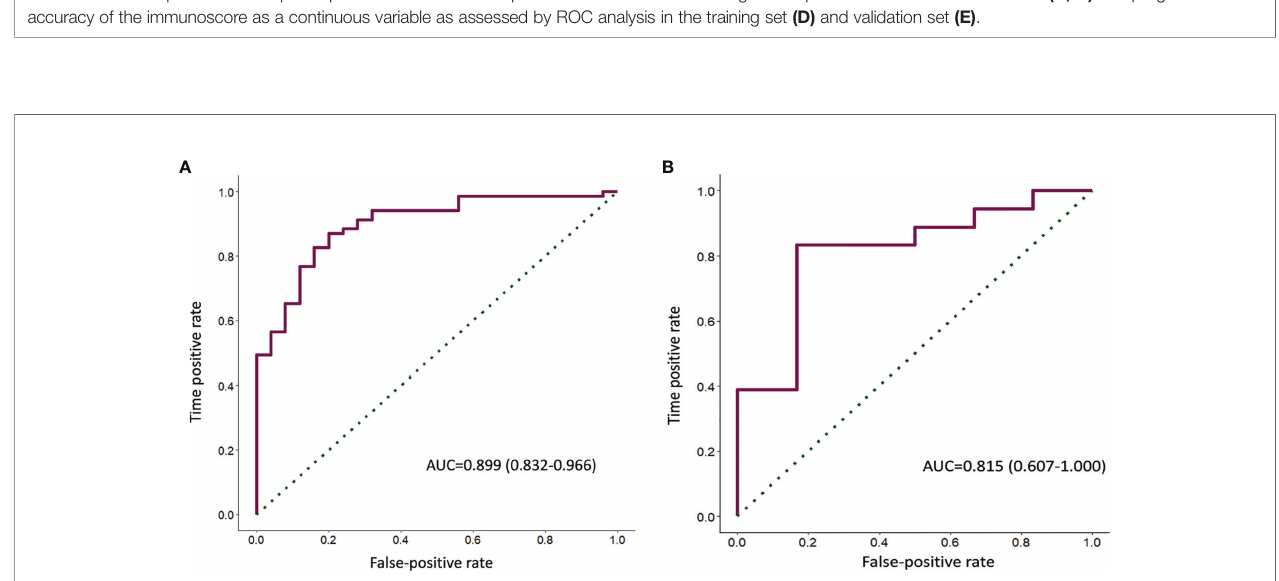
FIGURE 3 | ROC curves of the RIS predicted the ISBC in both the training (A) and validation sets (B) .